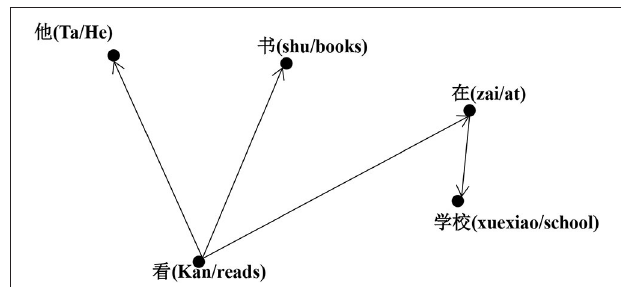
where k max is the maximum vertex degree of the network, and ρ is the network density calculated